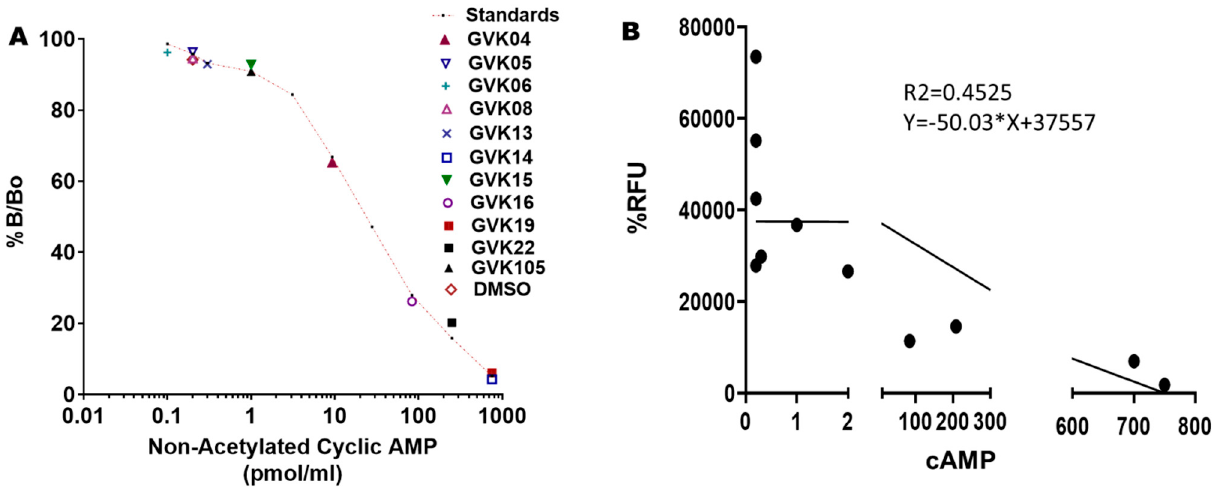
Figure 6. Changes in secreted cyclic AMP (cAMP) levels with the treatment of PDE inhibitors. Panel ( A ) : cAMP levels were measured using the Cayman ELISA kit after treating the Tulahuen strain of T. cruzi . The red-lined graph represents the standards of the cAMP provided by the manufacturer. All experiments were performed in triplicate, and the results are presented as means ± SEs. This is a competition assay, and the levels of secreted cAMP are shown on the X-axis. Statistical analysis was performed by two-way ANOVA, p < 0.05. Panel ( B ) : Represents the correlation graph that shows the treatment of analogs on RHM cells compared with the secreted cAMP levels. Graphs were created based on green fluorescence intensity, which is measured as % RFU intensity; DMSO control is shown as 100%. The 95% CI is − 0.8994 to − 0.1609, with a Pearson’s r-value of − 0.67. Table 3. Values of cAMP levels (pmol/mL) secreted in T. cruzi with respective xanthine analogs.